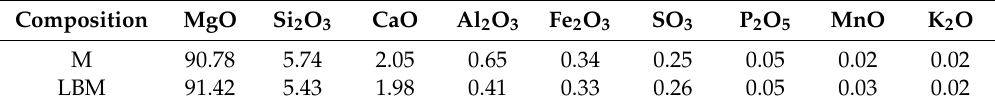
Table 1. Chemical composition of dead burnt magnesia (M) and light burnt magnesia (LBM) / %. Composition MgO Si 2 O 3 CaO Al 2 O 3 Fe 2 O 3 SO 3 P 2 O 5 MnO K 2 O M 90.78 5.74